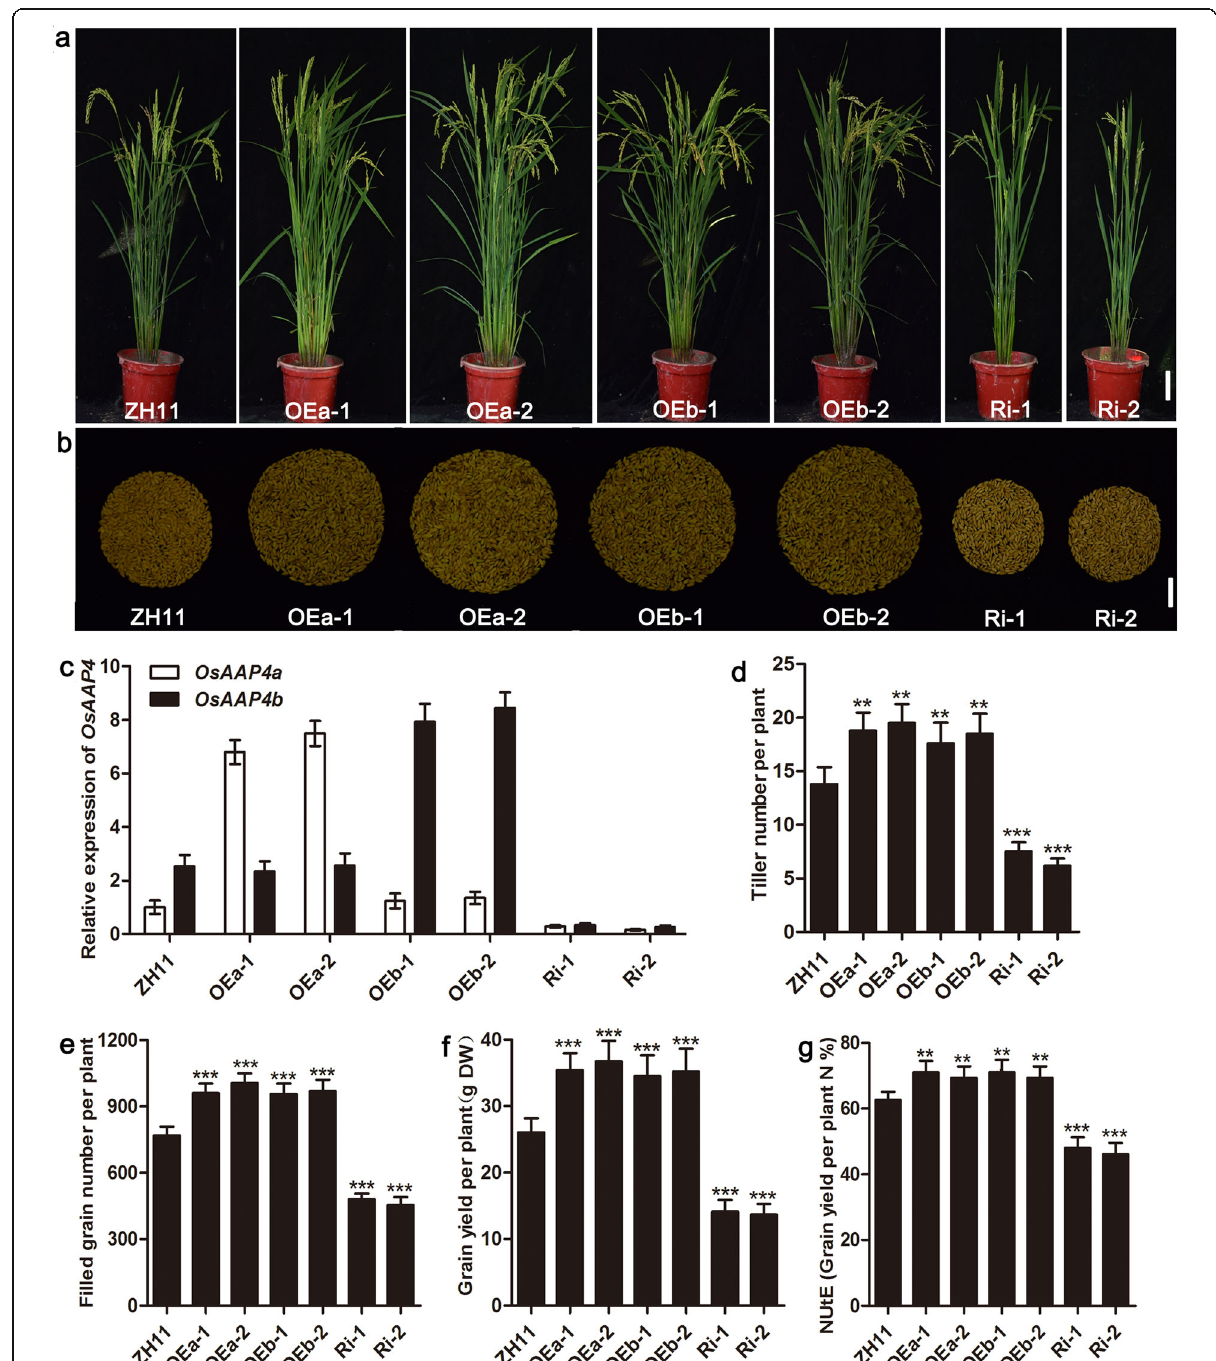
Fig. 3 Phenotypic analysis of OsAAP4 transgenic plants in the Japonica ZH11 background grown in Wuhan paddy fields. Whole-plant phenotype ( a ), grain yield phenotype ( b ), relative expression of OsAAP4 in the leaf blade ( c ), tiller number per plant ( d ), filled grain number per plant ( e ), grain yield per plant ( f ) and nitrogen utilization efficiency (NUtE) of transgenic plants and ZH11 ( g ). OEa-1 and OEa-2 indicate long variants of OsAAP4a- overexpressing lines, OEb-1 and OEb-2 indicate short variants OsAAP4b- overexpressing lines, and Ri-1 and Ri-2 indicate OsAAP4 -RNAi lines. The primers used for quantifying OsAAP4a expression was F: TGGCACTCACCCTTGCACAC, and R: CCGTCCACACCGTCCCTTGT, for quantifying OsAAP4b expression was ACTTGAGCTCTCTGCATTGGGT, and R: AGCGGTAGCAATTGGCGAGGA. The letters above the error bars are ranked by the T test, “ ** ” indicates a significant difference at p < 0.01, and “ *** ” indicates a significant difference at p < 0.001. Scale bar, 10.0 cm ( a ), 2.0 cm ( b ). Values are means ± s.d. ( n >